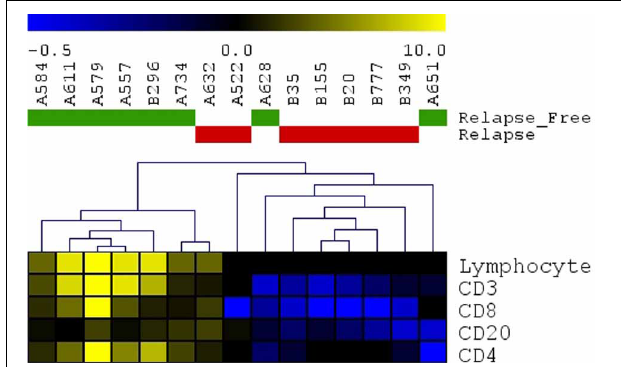
FIGURE 8 | Immunohistochemistry detection of infiltrating lymphocytes. Scoring results for CD3, CD4, CD8, CD20 detection as well as overall scoring of infiltrating lymphocytes (lymphocyte component). Heatmap presenting unsupervised hierarchical clustering results for 15 cut sections (7 samples with relapse and 8 samples without relapse). Relapse samples clustered together except for sample#A632. Relapse-free samples clustered together except for 2 samples (A628 and A651).